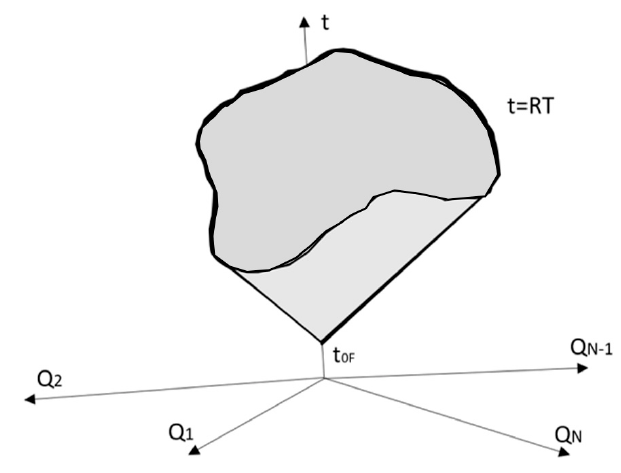
Figure 2. Multidimensional formulation of FR.